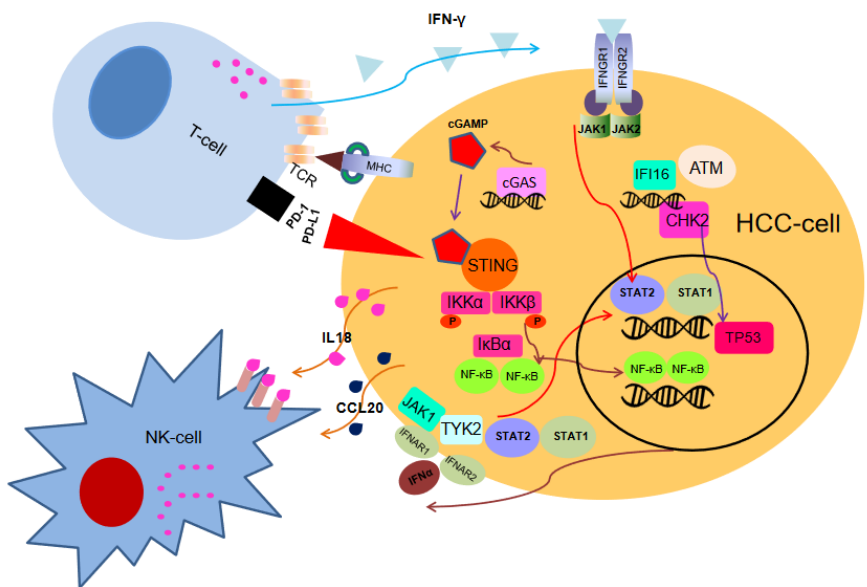
Figure 3. DNA damage promotes immune response. Endogenous or exogenous genotoxic stress triggers the accumulation of DNA damage, thereby forming DNA fragments. The DNA sensor cGAS binds to the DNA and uses GTP and ATP to catalyze the synthesis of cGAMP. cGAMP activates the endoplasmic reticulum (ER)-bound STING. NF- κ B released from IkBa is activated and translocates into the nucleus, where it induces transcriptional targets, including cytokines. The secreted IFNs binds to their heterodimeric receptor IFNAR1/2 or IFNGR1/2 and activates JAK phosphorylation of STAT1 and STAT2. The STAT1/2 heterodimer acts as a transcription factor and triggers the expression of cytokines (such as IL18, IL15, CCL20). STAT1/2 heterodimer acts as a transcription factor and triggers the expression of cytokines such as IL18, IL15, and CCL20.Cytokines activate immune effector cells (i.e., natural killer cells and T cells) by promoting tumor antigen/neoantigen presentation on the major histocompatibility complex I (MHC-I) and PD-1/ PD-L1 expression.